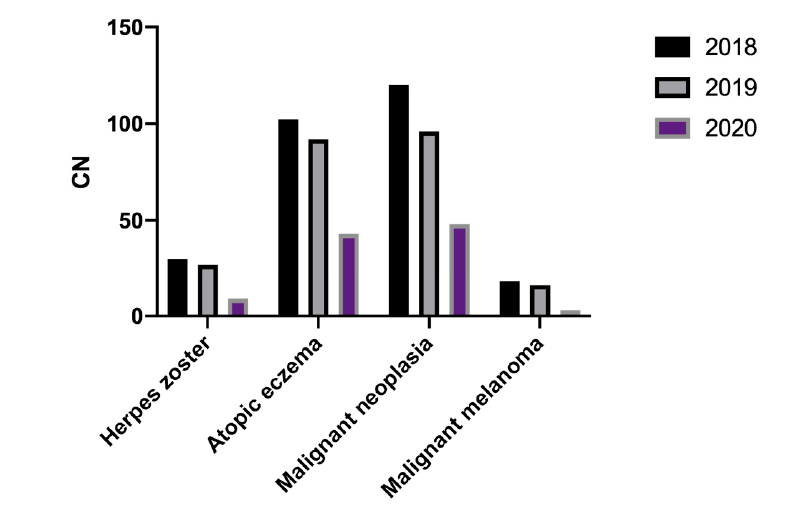
Figure 4. Absolute CN of herpes zoster, atopic eczema, malignant neoplasia, and malignant melanoma in March and April in 2018 (black column), 2019 (gray column), and 2020 (violet column). CN, case number.